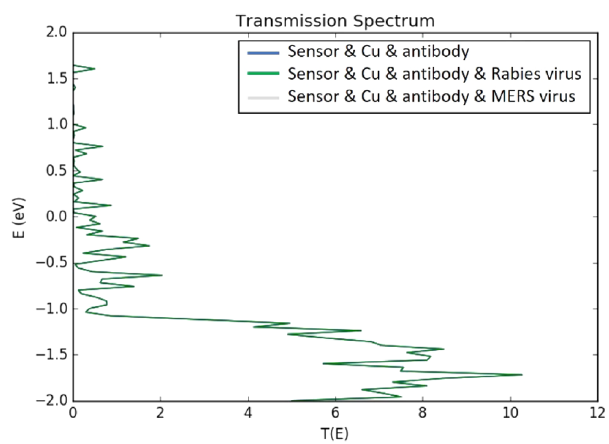
Figure 14. Transmission spectrums of SARS-CoV-2 human neutralizing antibody decorated sensors before and after addition of Rabies and MERS viruses. Produced by QuantumATK software (version